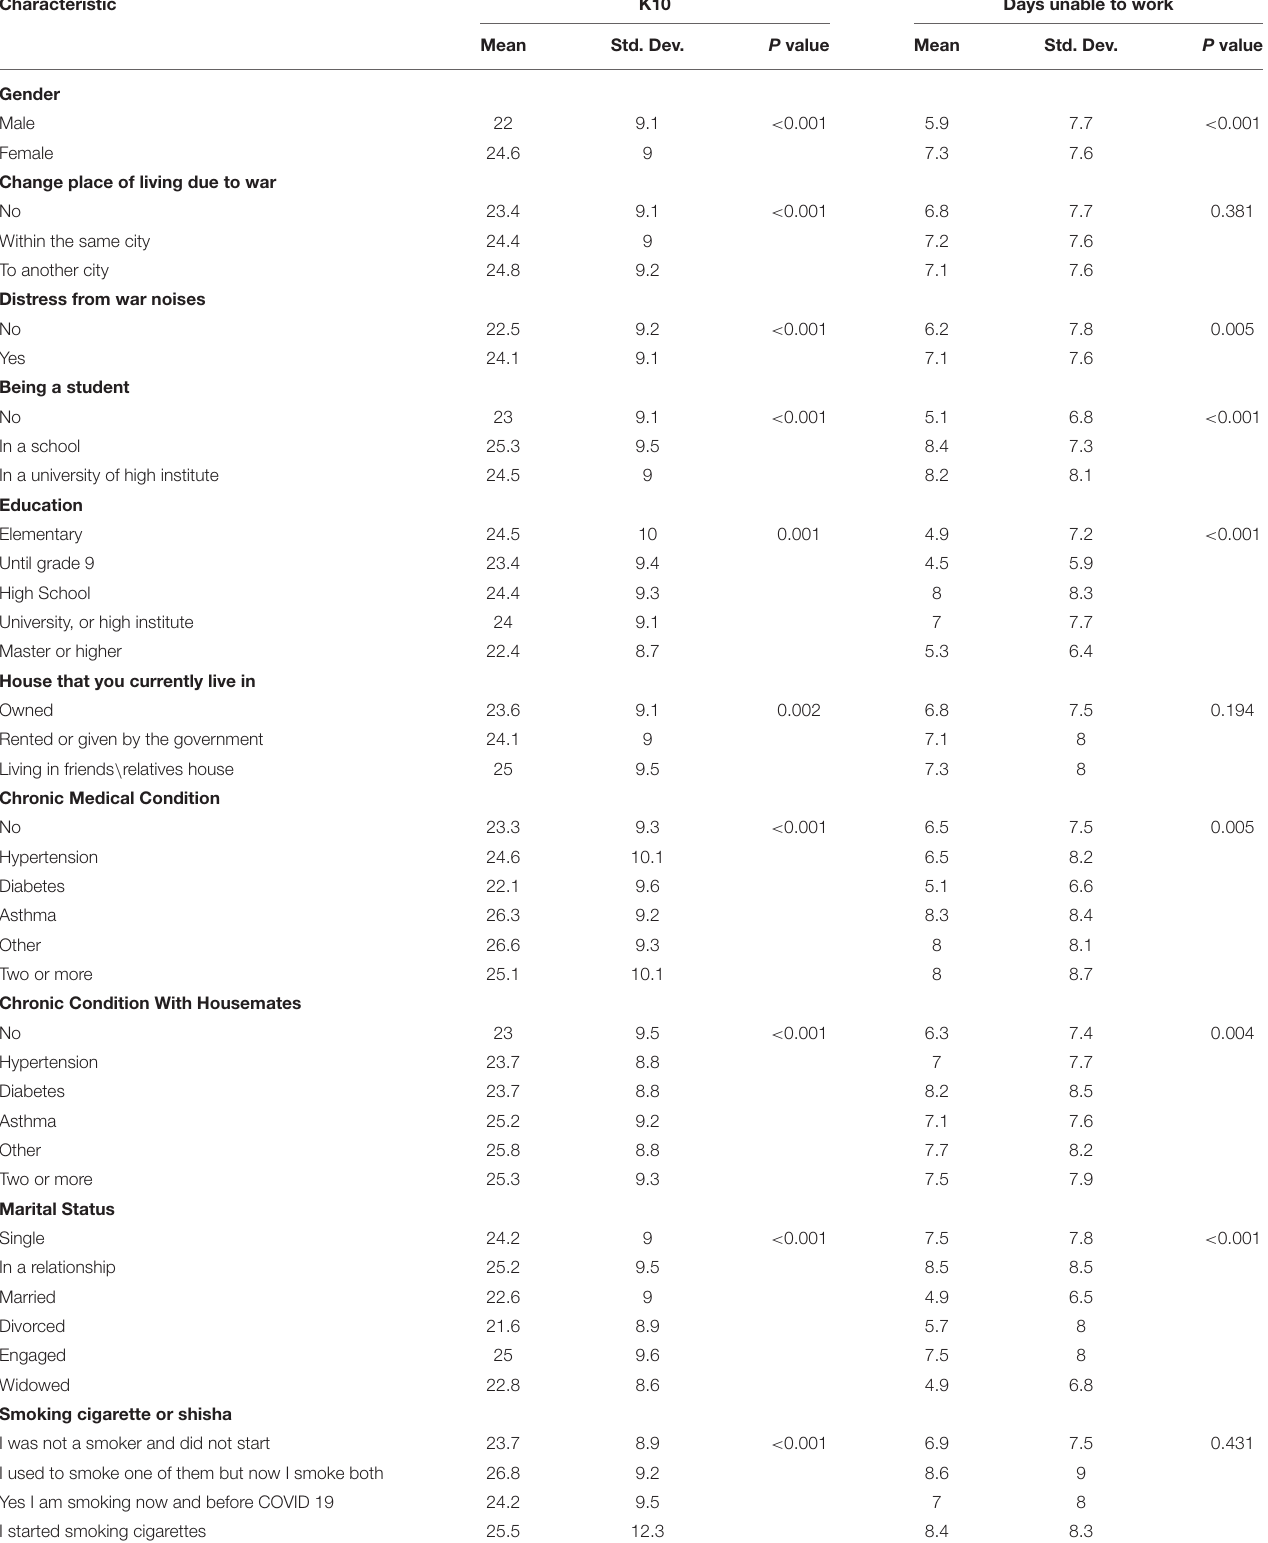
TABLE 5 | K10 scores, days unable to work and days of reduced work and correlations with COVID-19 and war variables along with other variables. Characteristic K10 Days unable to work Mean Std. Dev. P value Mean Std. Dev. P